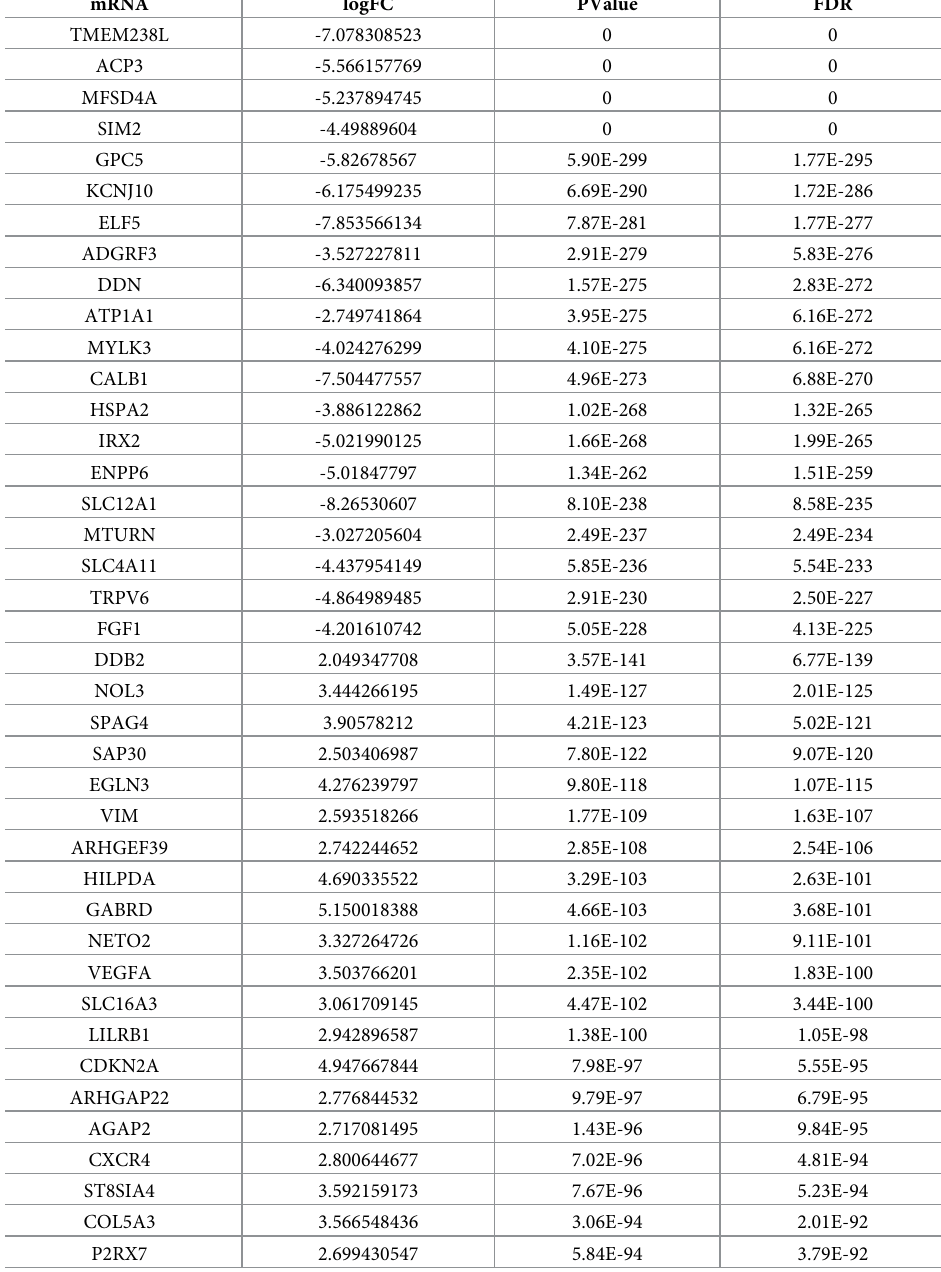
Table 3. Top 20 upregulated and downregulated mRNA in patients with KIRC.